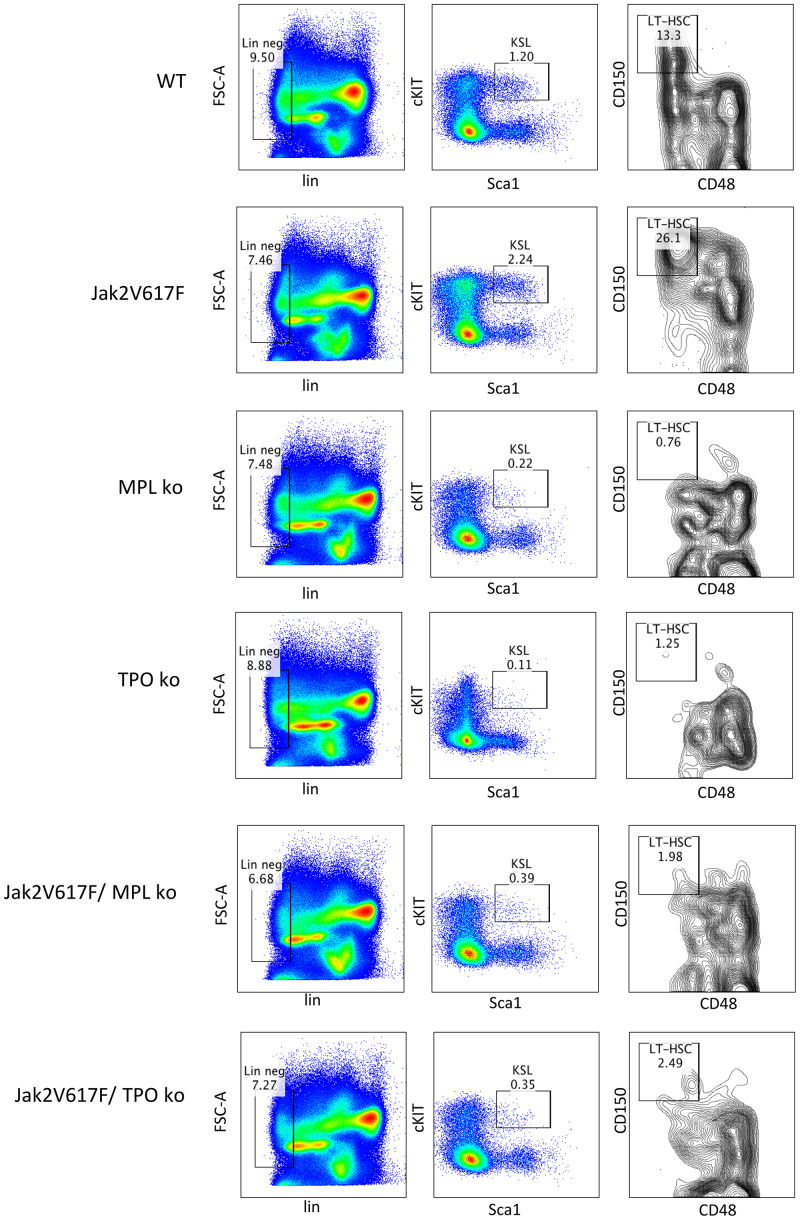
MPLdel and THPOdel genotypes reduce the LT-HSC (CD150+CD48-) population in a JAK2V617F transgenic mouse model of PV.Flow cytometry of marrow LT-HSC at > 16 weeks in wild-type (n = 4), MPLdel/del (n = 3) and THPOdel/del (n = 3) mice and JAK2V617 (n = 4), JAK2V617F/MPLdel/del (n = 3) and JAK2V617F/THPOdel/del (n = 3) transgenic mice. The marrow LT-HSC population was 13% of the total LSK population in wild-type mice, 26% of the total LSK population in JAK2V617F transgenic mice and 0.76% and 1.25% respectively in the MPLdel/del and THPOdel/del mice and 1.98 and 2.08% respectively of the total LSK population in JAK2V617F/MPLdel/del and JAK2V617F/THPOdel/del transgenic mice. WT vs JAK2V617F, P <0.029; MPLdel/del vs JAK2V617F, P < 0.022; THPOdel/del vs JAK2V617F, P <0.021; JAK2V617F vs JAK2V617F/MPLdel/del, P < 0.023; JAK2V617F vs JAK2V617F/THPOdel/del, P < 0.034. The number (n) of mice of each genotype studied is in parentheses.